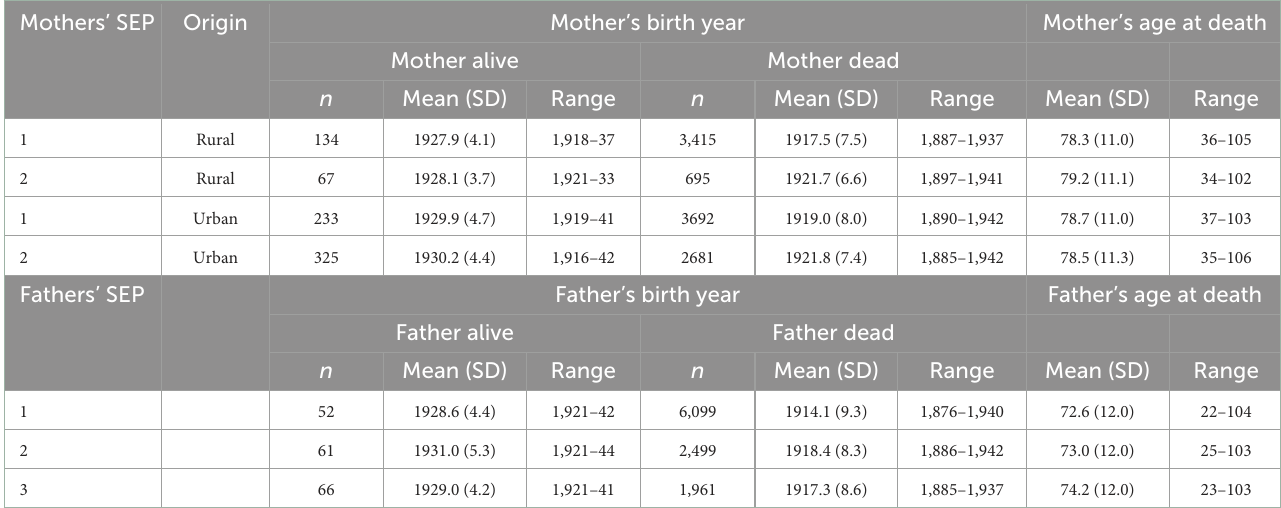
TABLE 1 Descriptive statistics for parents’ birth years and ages at death in a sample used for analyzing association between offspring anthropometric traits and parental longevity. Mothers’